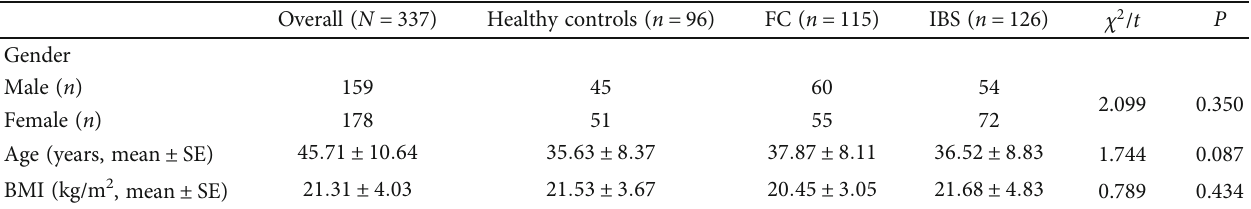
Table 1: Demographics and characteristics of the three groups (healthy controls, functional constipation, and irritable bowel syndrome) in this